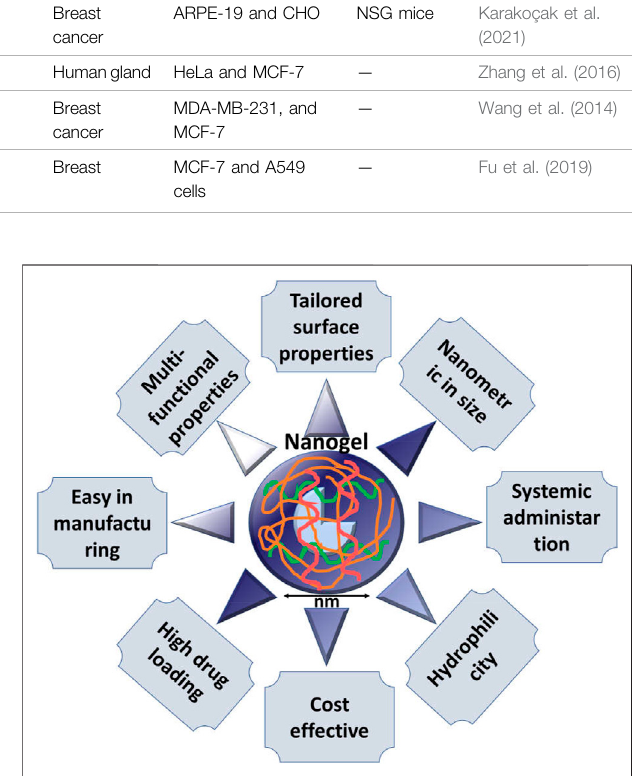
FIGURE 7 | Schematic illustration of the different characteristics of